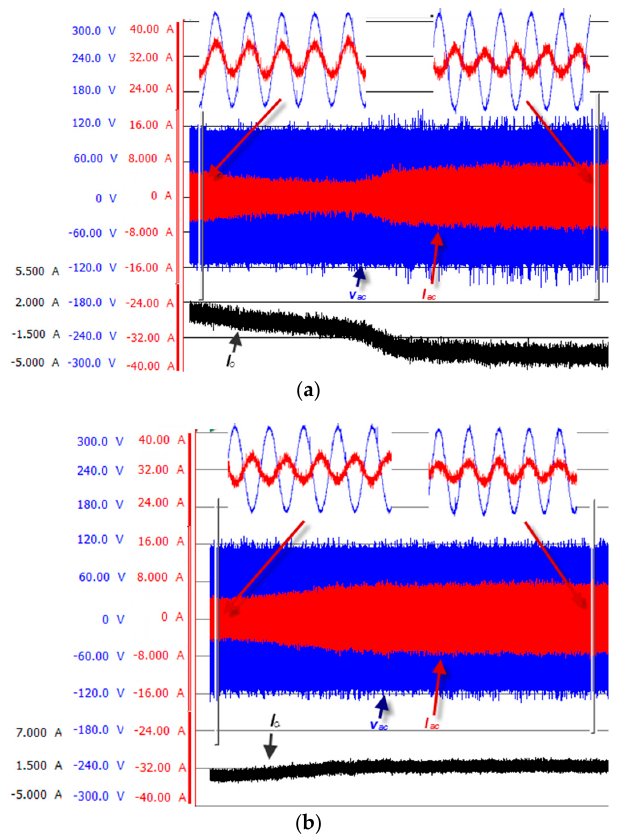
Figure 19. Change of the working mode ( a ) rectifier to inverter and ( b ) inverter to rectifier.